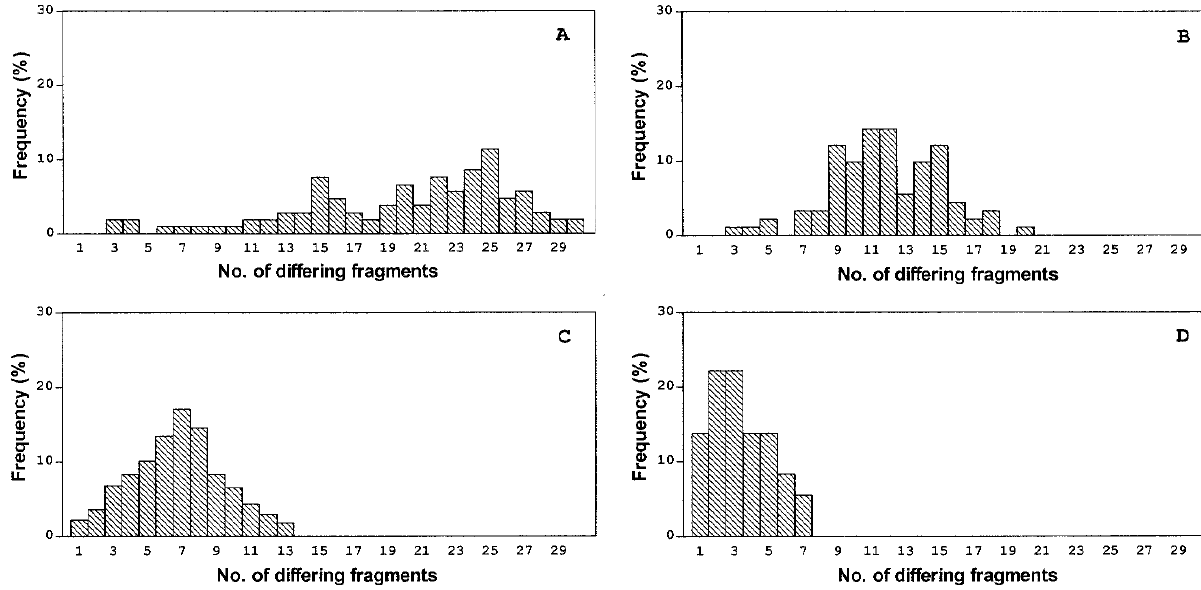
O, negative control with sterile distilled 2